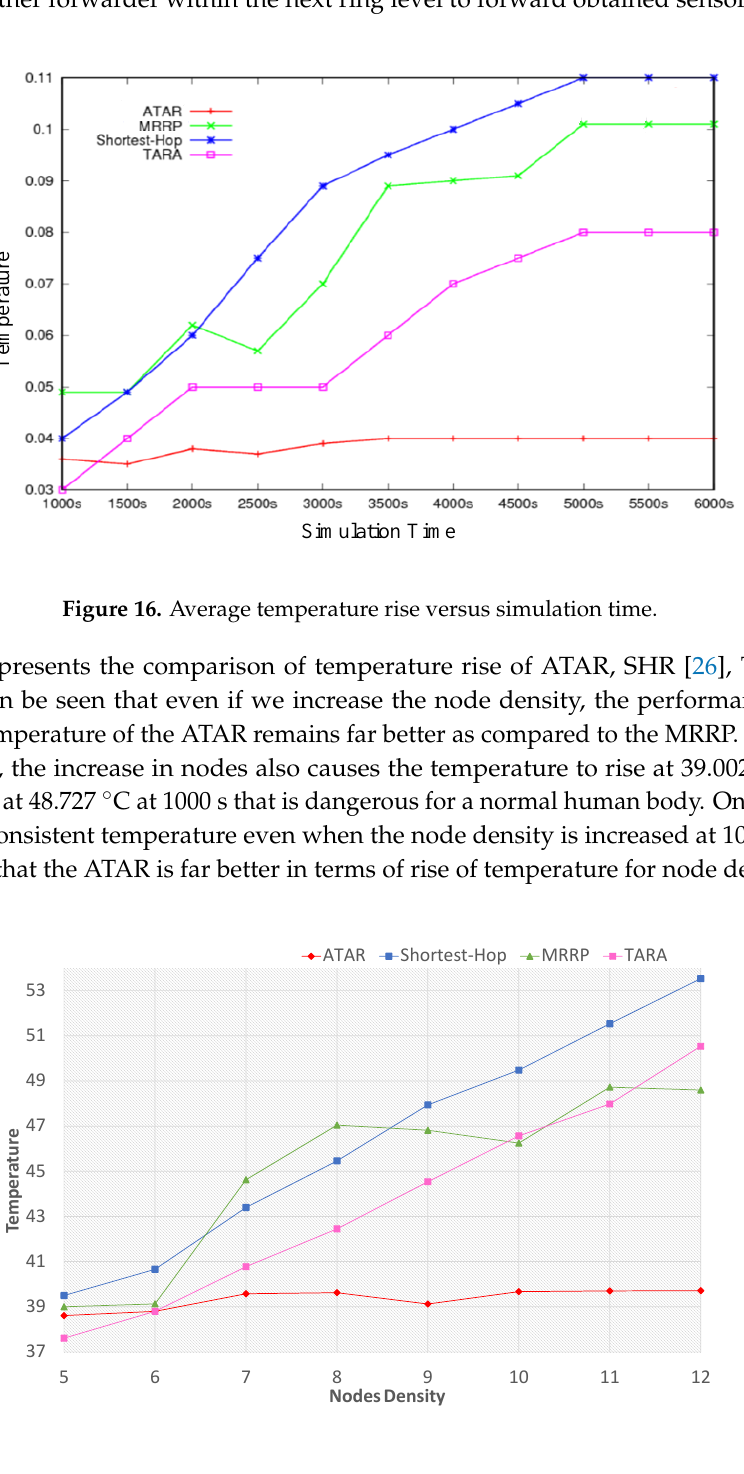
Figure 17. Average temperature with different nodes density at simulation time = 1000